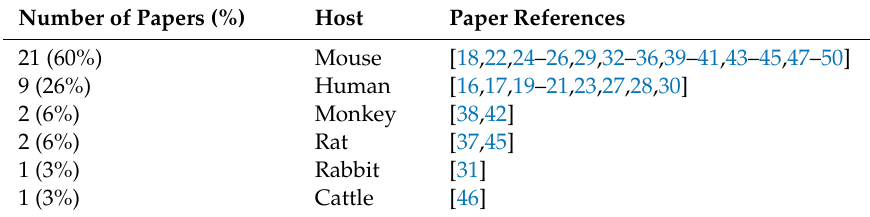
Table 1. The number of papers that included dose-response studies for each host species identified in the